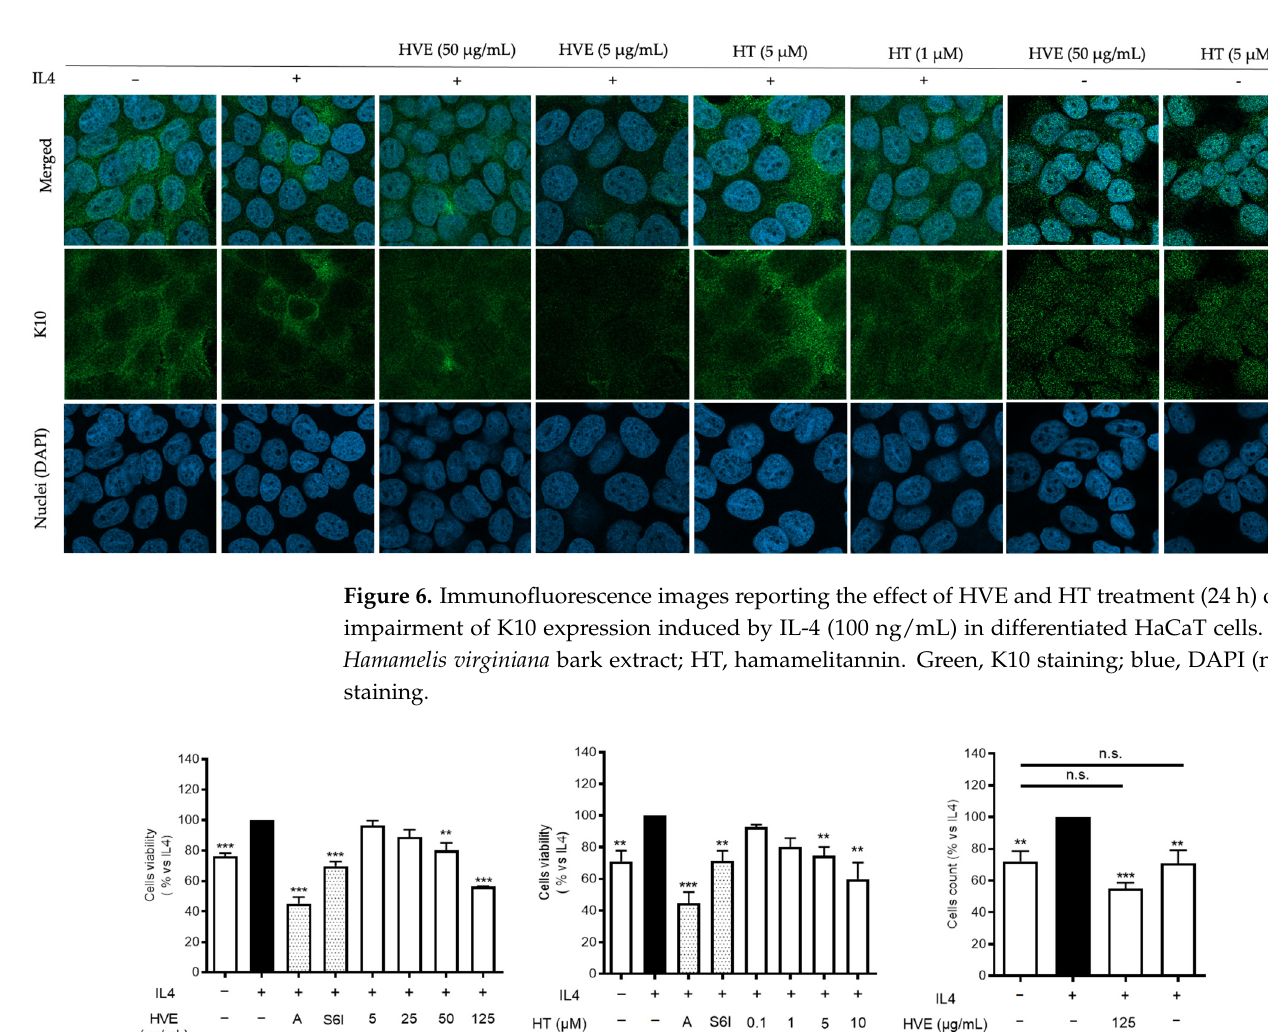
Figure 6. Immunofluorescence images reporting the effect of HVE and HT treatment (24 h) on the impairment of K10 expression induced by IL-4 (100 ng/mL) in differentiated HaCaT cells. HVE, Hamamelis virginiana bark extract; HT, hamamelitannin. Green, K10 staining; blue, DAPI (nuclei) staining.